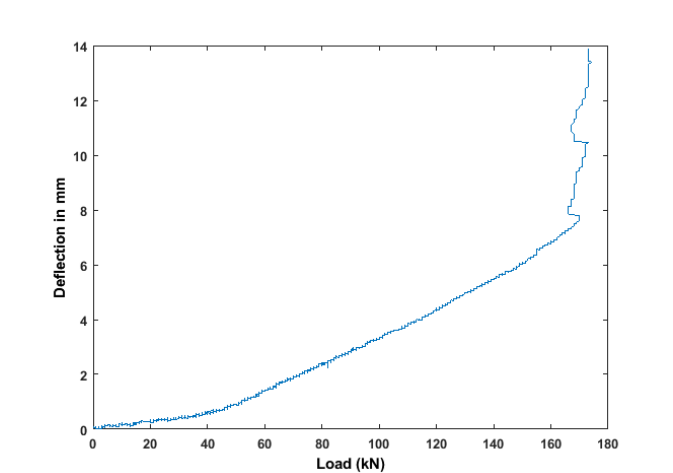
Figure 11. Deflection (LVDT) and